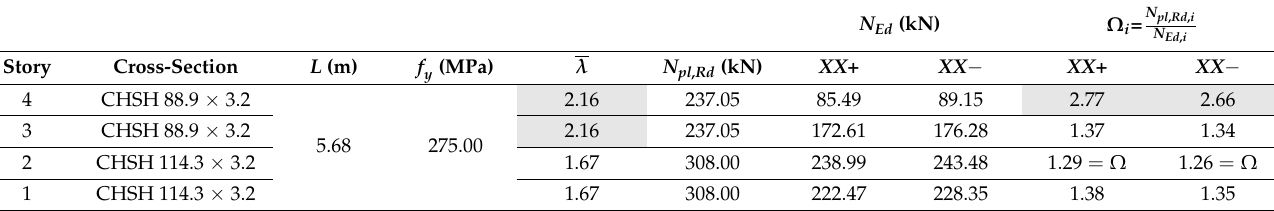
Table 2. Steel braces design results: q = 3.0 (DCM).